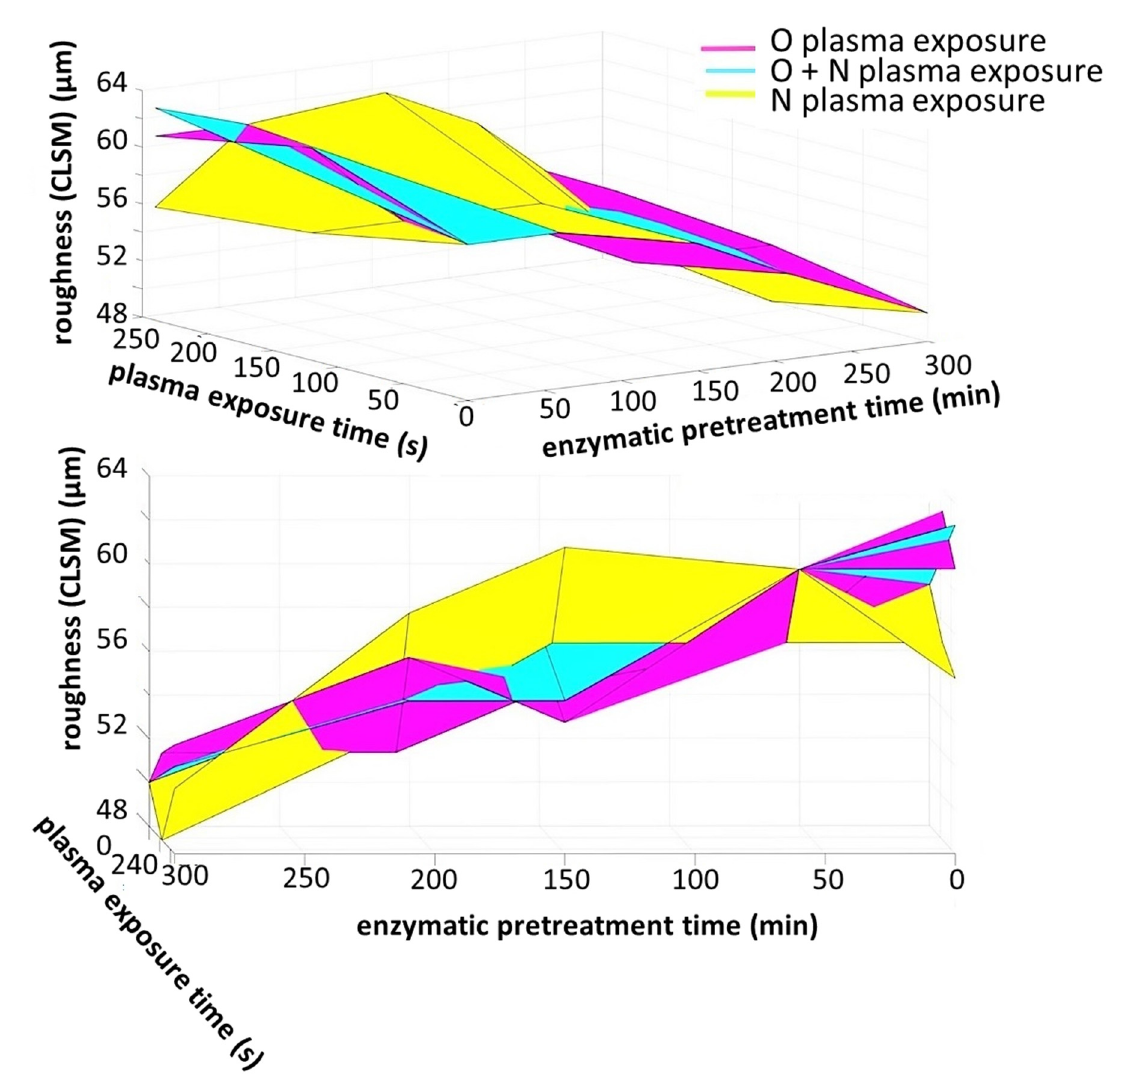
Figure 11. Constructed interpolated 3D relationship surfaces showing the interplay between extending plasma exposure time and enzymatic pretreatment time. The difference between the more aggressive etching of O plasma and N plasma can be easily discerned.